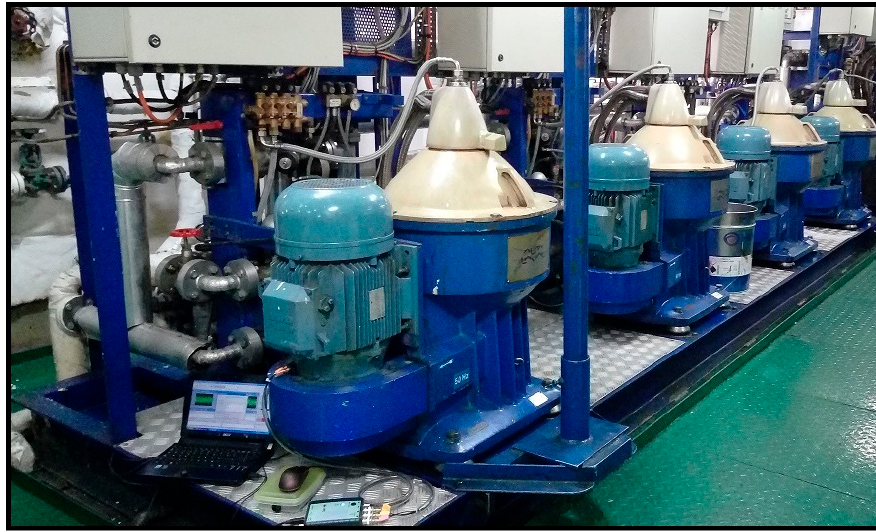
Figure 1. Lube oil centrifugal separator systems. Table 1. Technical characteristics of the centrifugal separator systems.